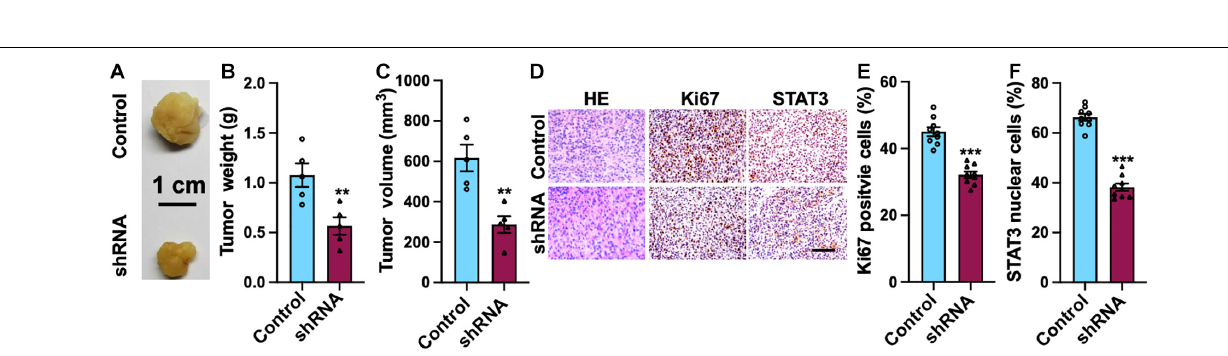
Frontiers in Cell and Developmental Biology |